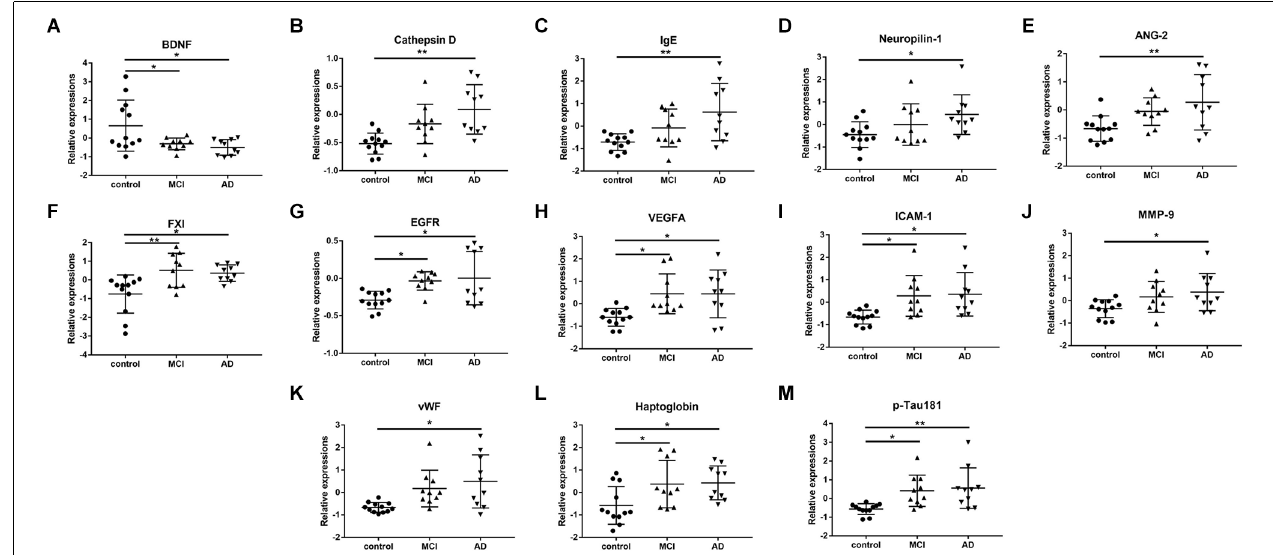
FIGURE 2 | The scatter plots showed the detail comparisons of serum levels of identified potential biomarker proteins between the control, mild cognitive impairment (MCI), and Alzheimer’s disease (AD) groups. (A) Brain derived neurotrophic factor (BDNF); (B) Cathepsin D; (C) Immunoglobulin E (Chen et al., 2020); (D) Neuropilin-1; (E) Angiopoietin-2 (ANG-2); (F) Coagulation factor XI (FXI); (G) Epidermal growth factor receptor (EGFR); (H) Vascular endothelial growth factor A (VEGFA); (I) Intercellular adhesion molecule -1 (ICAM-1); (J) Matrix metalloproteinase-9 (MMP-9); (K) von Willebrand factor (vWF); (L) Haptoglobin; (M) Phosphorylated Tau-181 (p-Tau181). * P < 0.05, ** P < 0.01.